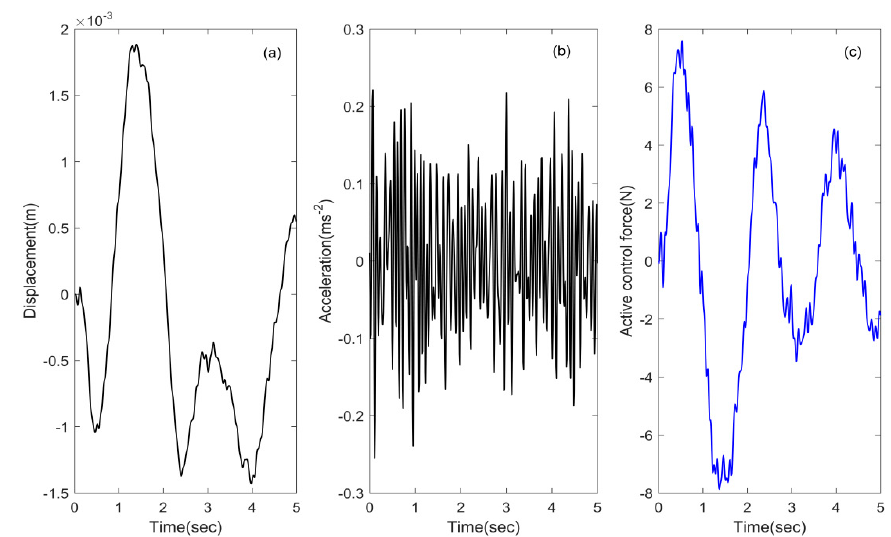
Figure 3. The displacement and acceleration responses ( a , b ), and ( c ) control forces (6) of the hybrid isolator with quasi-zerostiffness (QZS) for case (i).